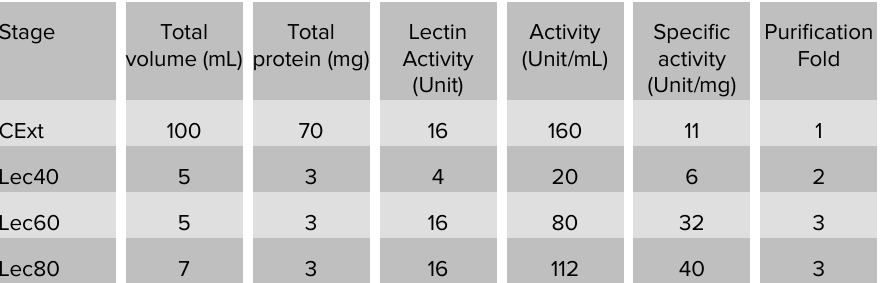
Table 2: Partial purification of isolectins from Jatropha curcas